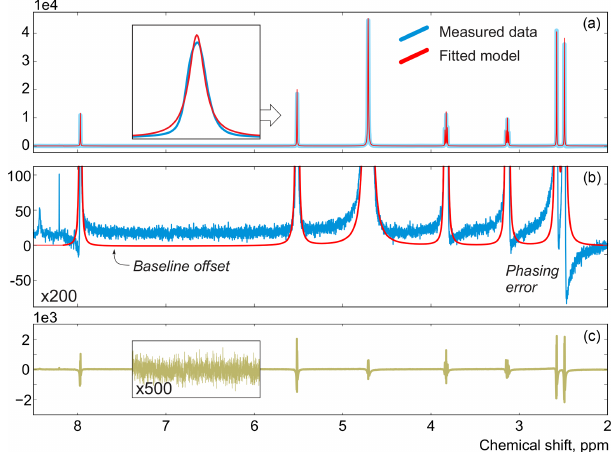
Figure 2. (a) An example of a least-squares model fit to a spectrum of thiamine acquired on a 400MHz spectrometer. (b) A close-up view of the spectrum. Note that in order to fit Lorentzian peaks to the experimental data, the minimization of Eq. (3) distorts the phas- ing and forces a constant residual offset in the baseline. (c) The residual spectrum after fit; instead of containing only random noise, the residual is dominated by large spikes caused by imperfect fit of the